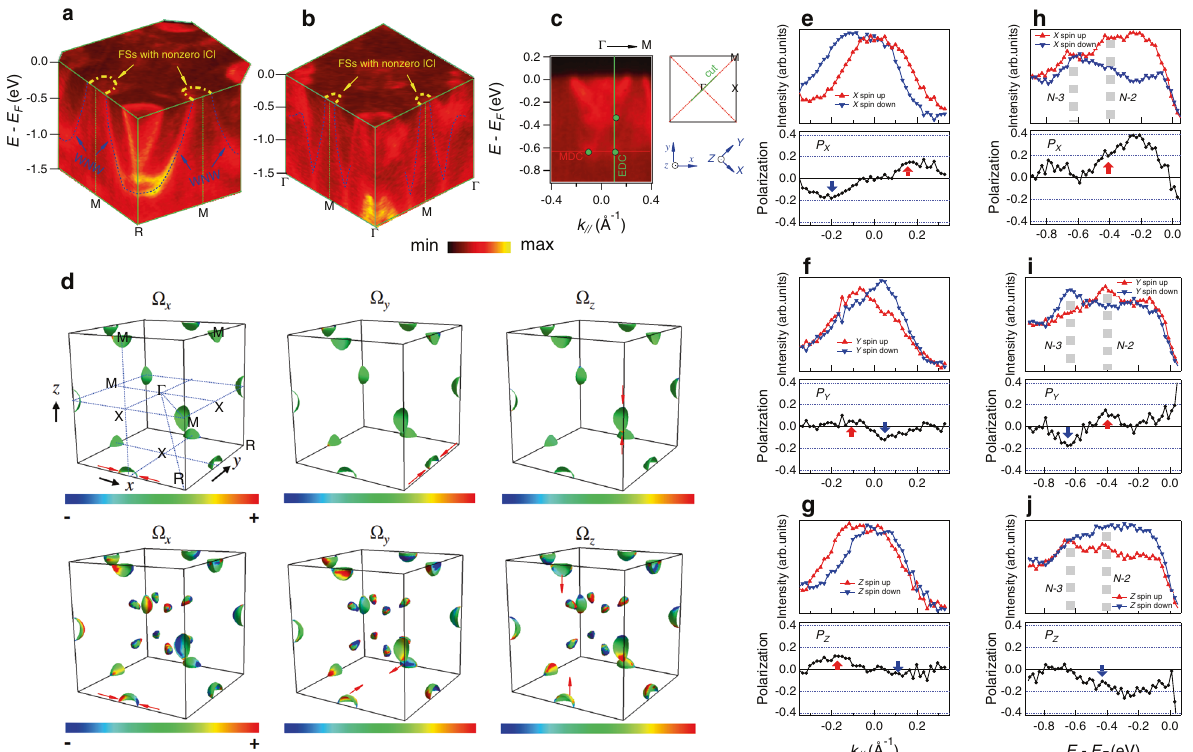
Fig. 3 Fermi surfaces with nonzero Chern number near M points, and spin polarization of the bands near the singular Weyl point. a , b 3D band structure along the R – M – X plane and Γ – X – M plane showing the FS pockets with nonzero Chern number around M points, respectively. The Fermi surfaces are contributed by the cross-section with Fermi level of the two single degenerate bands forming the singular Weyl point and WNW. c Spin-integrated band structure along Γ – M near the singular Weyl points. The MDC and EDC lines indicate the location of the spin measurements. The green dots show the spin-polarized peak position of the bands near the singular WP. d The top row shows the Berry curvature fi eld along the x , y , z directions on the Fermi surface formed by band N − 3. The bottom row shows the Berry curvature fi eld along the x , y , z directions on the Fermi surface formed by band N − 2. e – g Measured spin-resolved intensity, along the MDC line in c , projected on the X , Y , Z directions, respectively. The red and blue symbols are the intensity of the spin-up and spin-down states, respectively. The black curves indicate the spin polarization curves. h – j Same as e – g but along the EDC line in c . The spin measurements are taken with circular positive polarized (CP) light